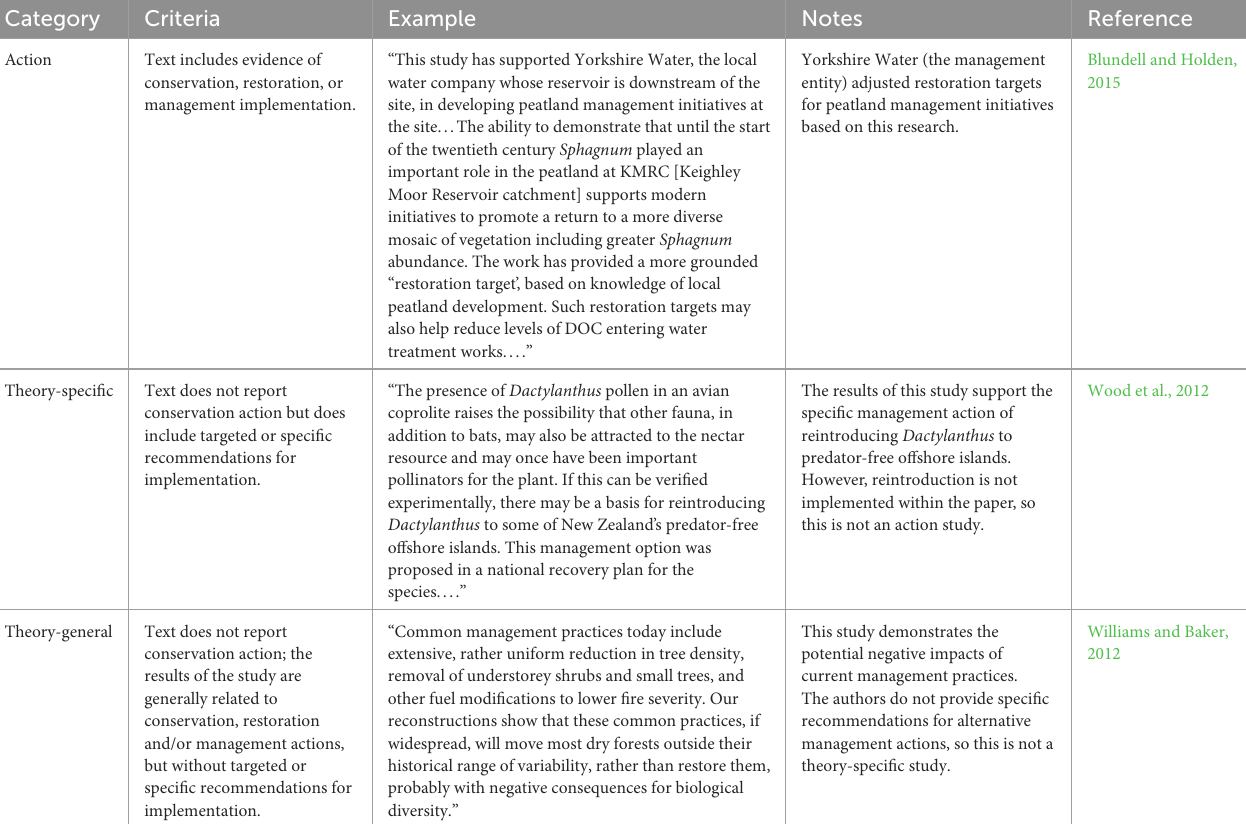
TABLE 2 Criteria for determining inclusion of an applied conservation paleobiology study into “action”, “theory-general”, and “theory-specific”